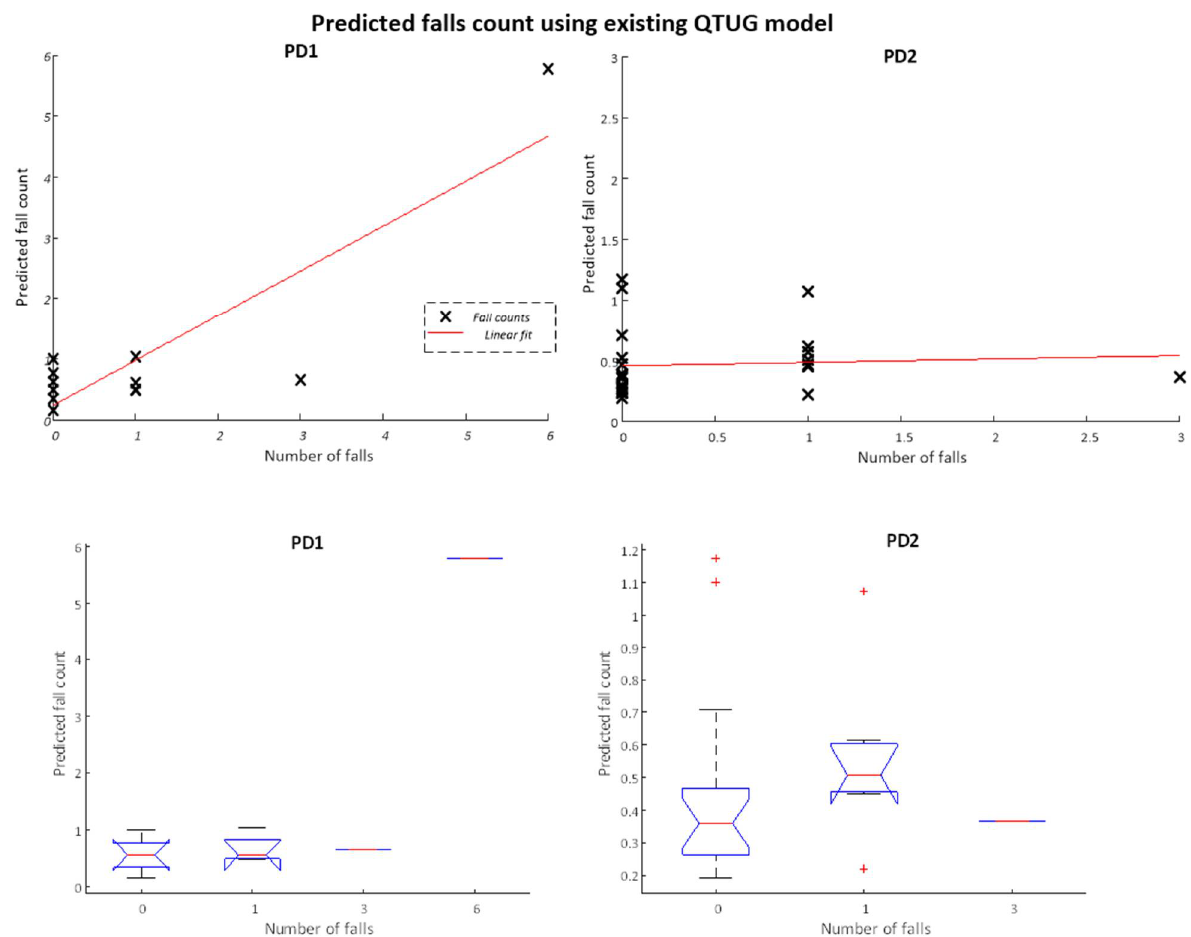
Figure 4. Predicted falls count versus actual number of falls for existing QTUG data model tested on independent PD test datasets (PD1 (left and PD2 (right)). For PD1 dataset, outliers (Number of Falls >10) are removed, for PD2 data set the maximum fall count for any participant was 3. Top panels plot actual fall counts against predicted while bottom panels group fall counts into buckets (0–6).